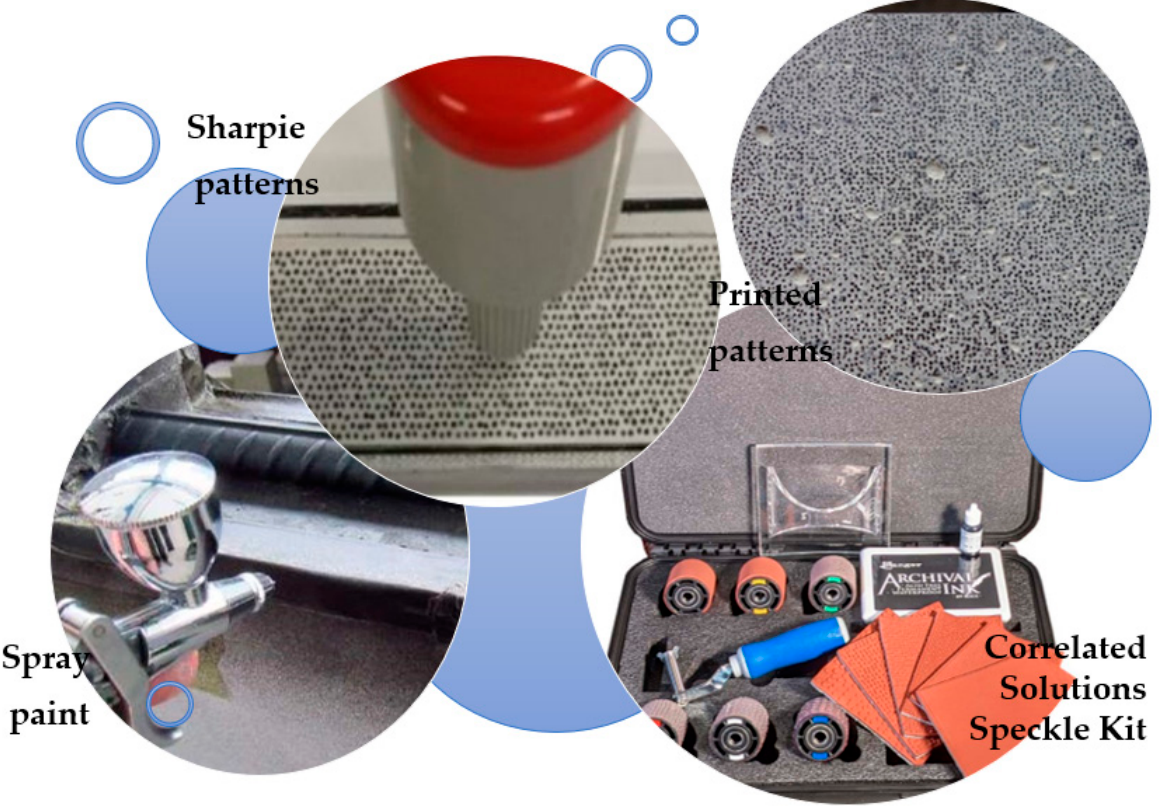
Figure 5. Common pattern application methods ([62,64,65]).